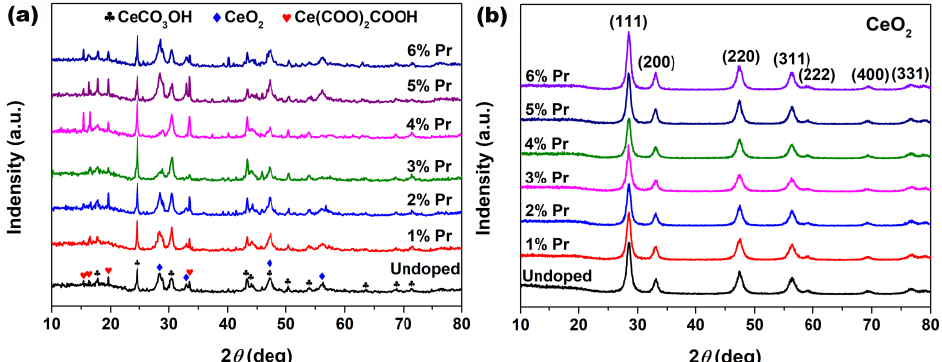
Figure 1. XRD patterns of the samples synthesized solvothermally at 200 °C for 24 h with different Pr concentrations ( a ) before and ( b ) after calcination in air at 500 °C for 2 h.